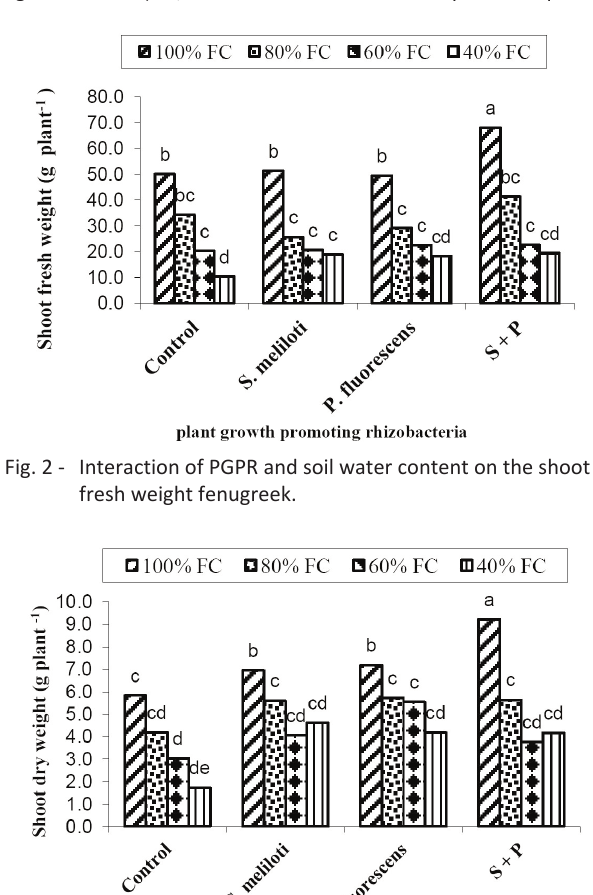
Dissimilar letters indicating significant differences (Duncan’s multiple range test P≤0.01). N, P and k were measured in dry shoot of plant.